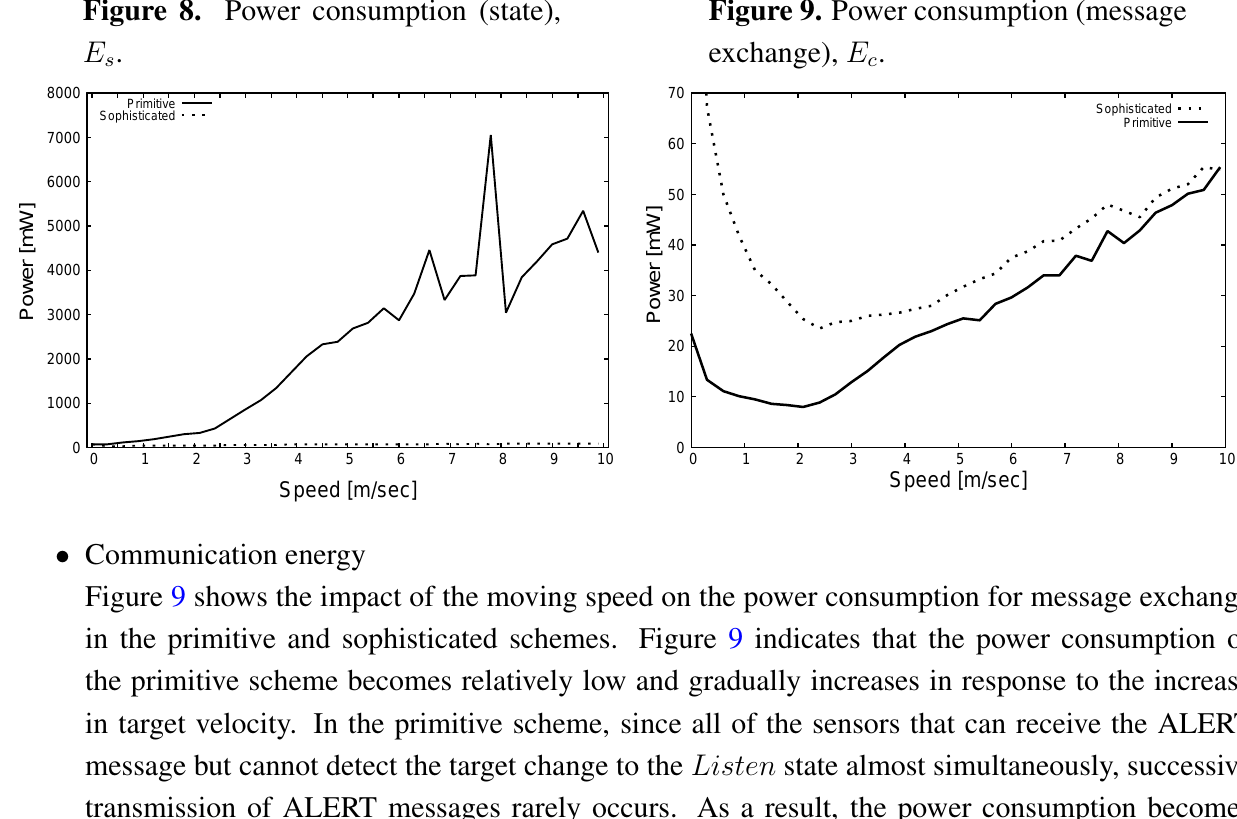
Figure 9. Power consumption (message exchange), E c